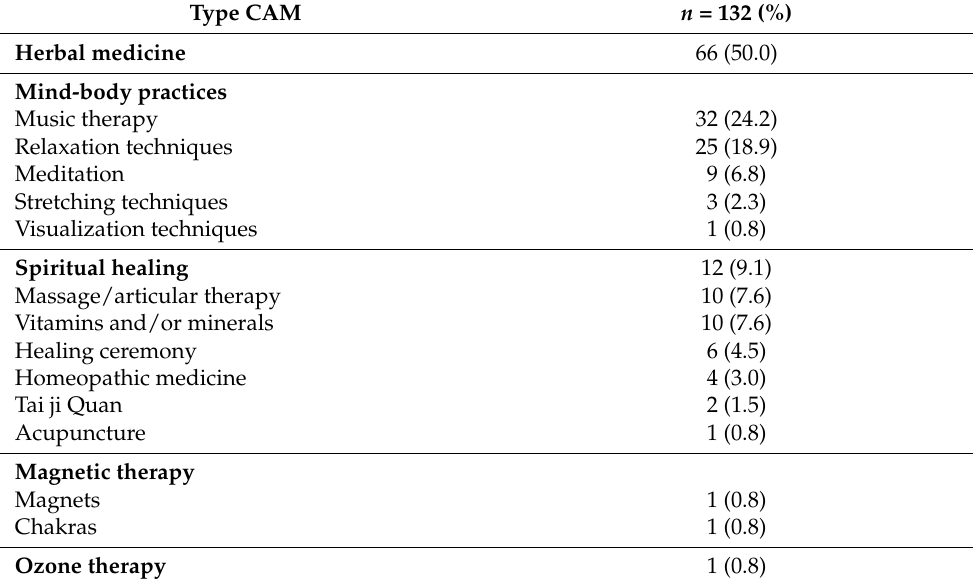
Table 2. Distribution of types of CAM used by